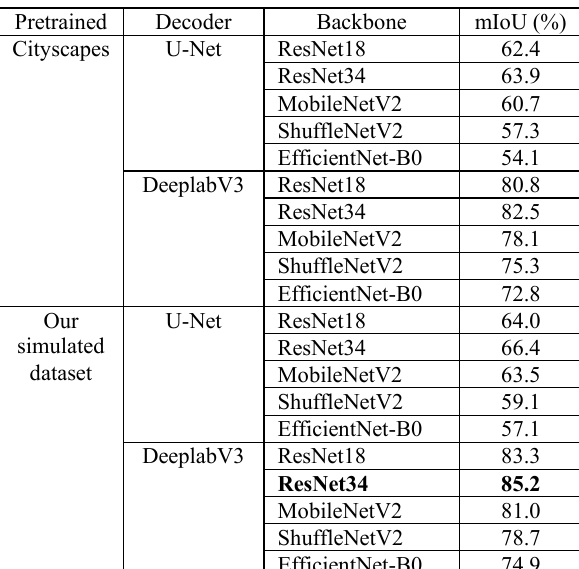
Table 3. Our off-road validation set